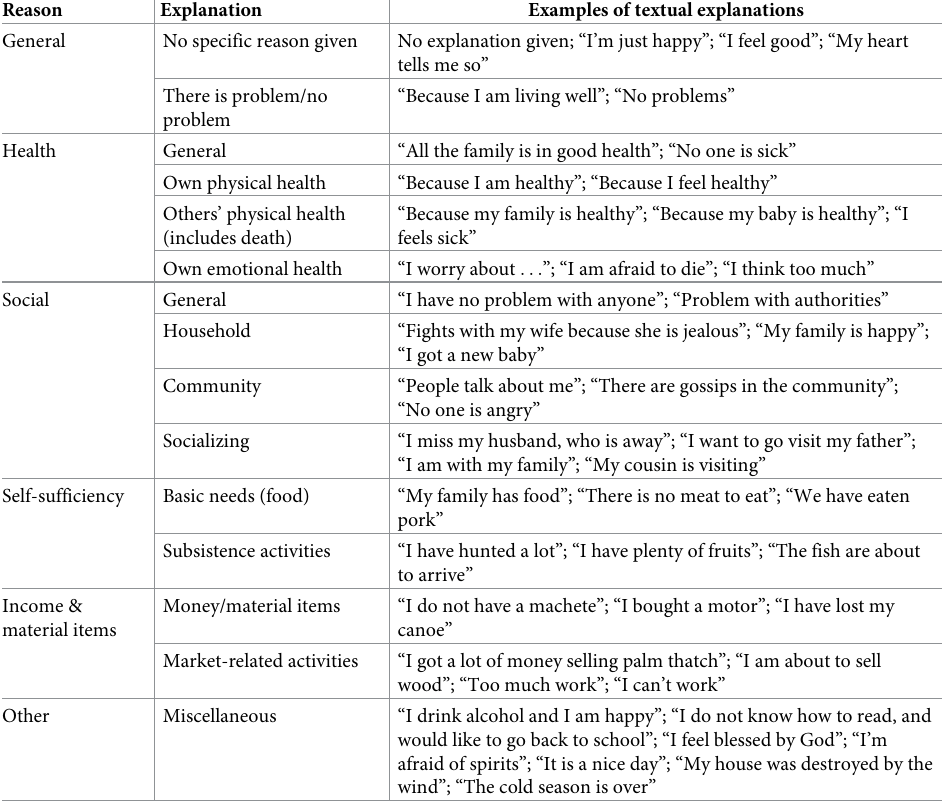
Table 1. Coding of textual explanations of individual life satisfaction